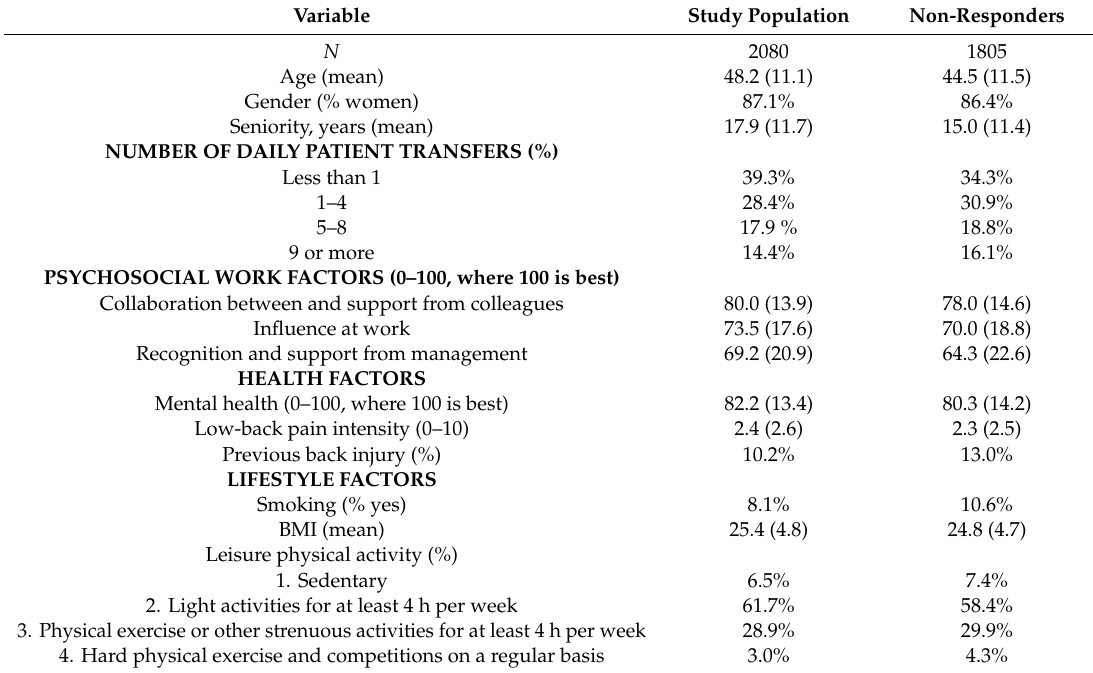
Table 1. Demographics, work, health, and lifestyle at baseline. Results are either mean (SD) or prevalence as percentage (%) of the study population. BMI: body mass